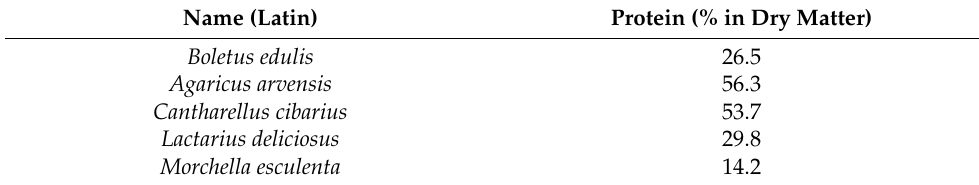
Table 2. Protein in some edible mushrooms (as % in dry matter)